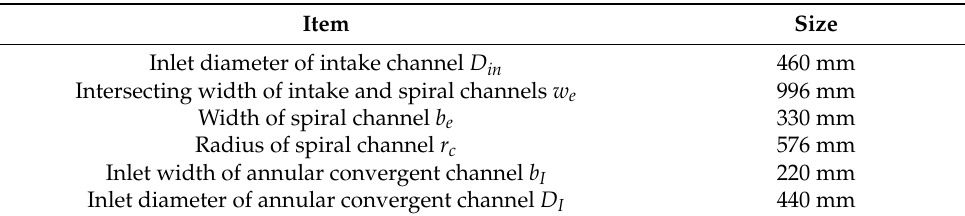
Table 4. Geometric parameters of the improved radial inlet chamber.